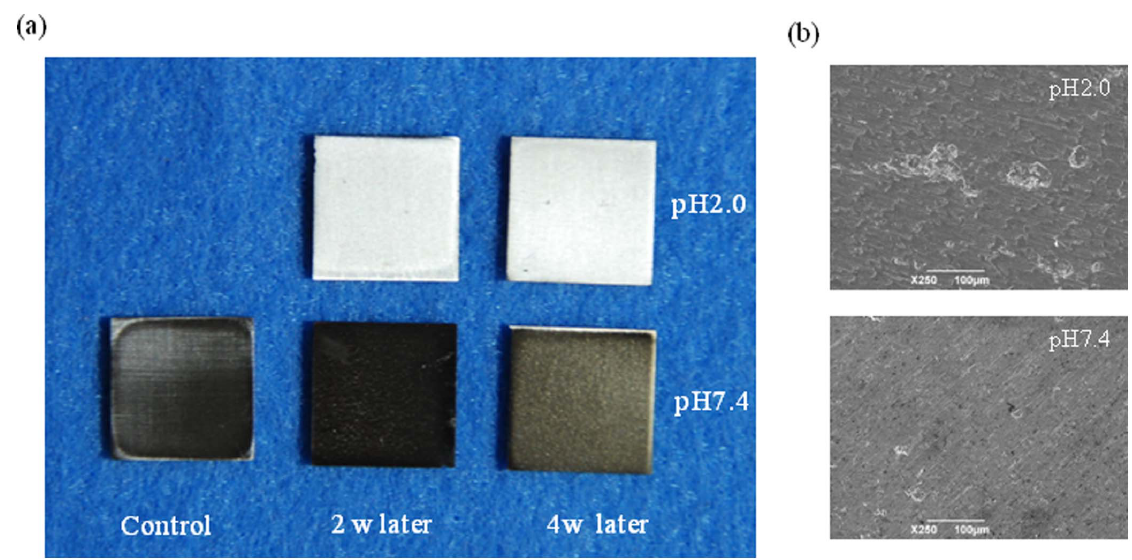
Figure 3. Stereoscopic images of the surfaces of specimens of CP Ti immersed for 2 and 4 wk in SBF solutions(a), SEM image of CP Ti surfaces in immersing for 4 wk in SBF solutions(b).